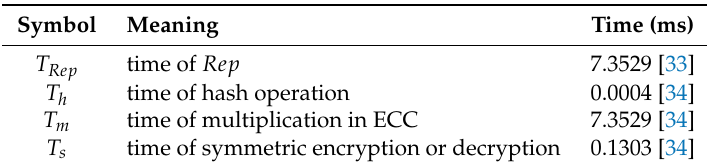
Table 4. Notations of Time Symbol.